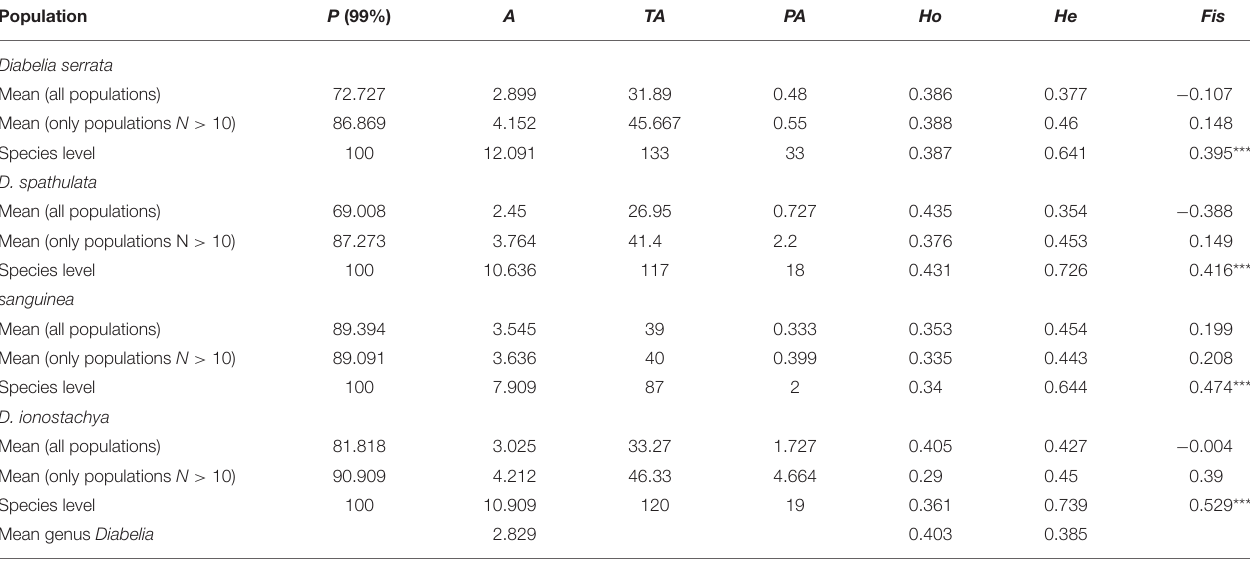
TABLE 4 | F -statistics of the five gene-pool (the result of STRUCTURE-nSSR) and four species within Diabelia . Population Fst Fsc Fct Percentages of molecular variance Lineage Among species